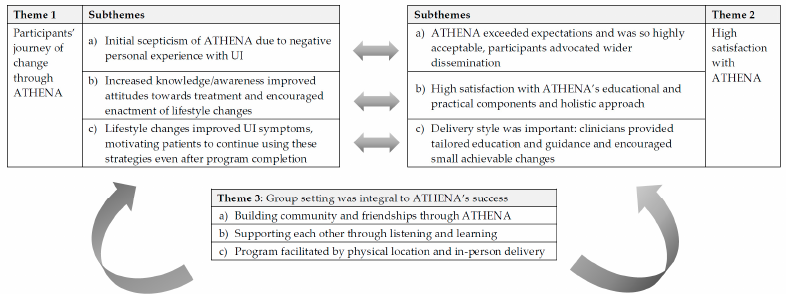
Figure 1. Conceptual model of ATHENA’s mechanisms of action. Note: Themes 1 and 2 interacted with each other, in that: (i) despite initial scepticism of ATHENA (due to negative personal